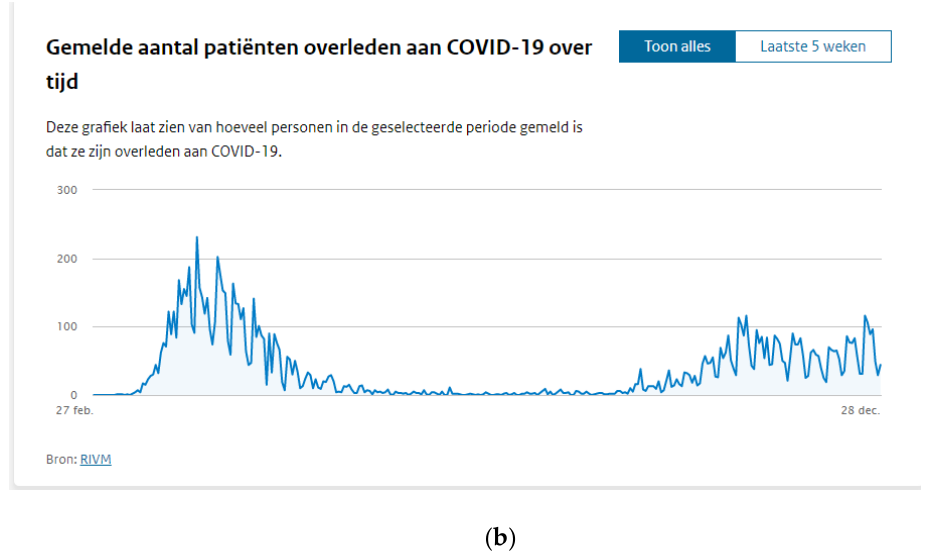
Figure 5. ( a ) Dashboard Netherlands—number of positive cases per 100,000 inhabitants between 2